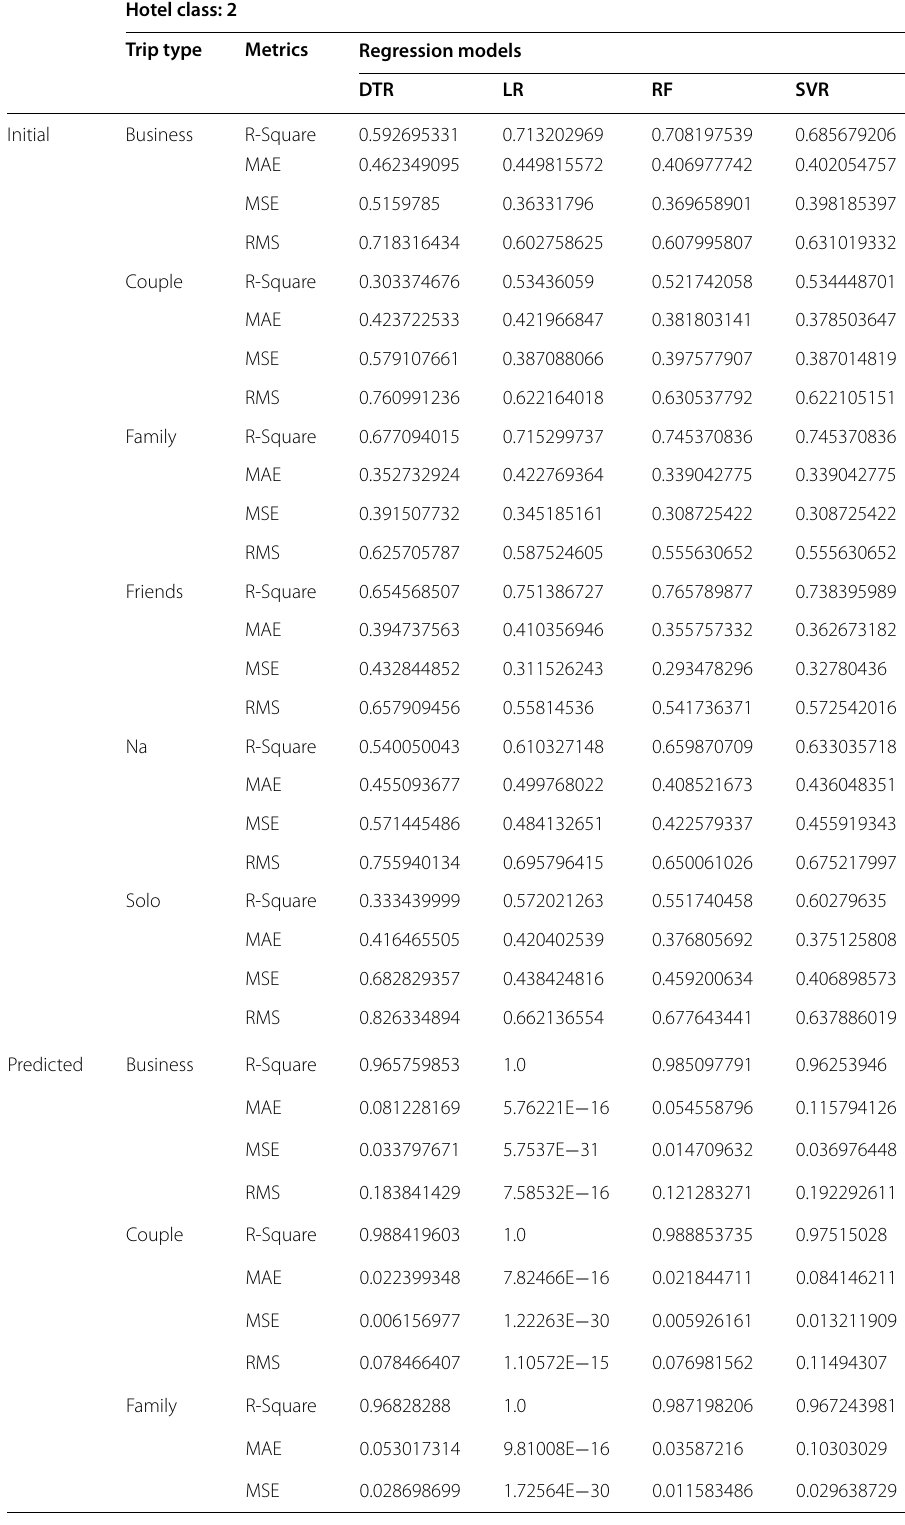
Table 6 Accuracy analysis on 2 star hotel class based on trip type (Initial and predicted